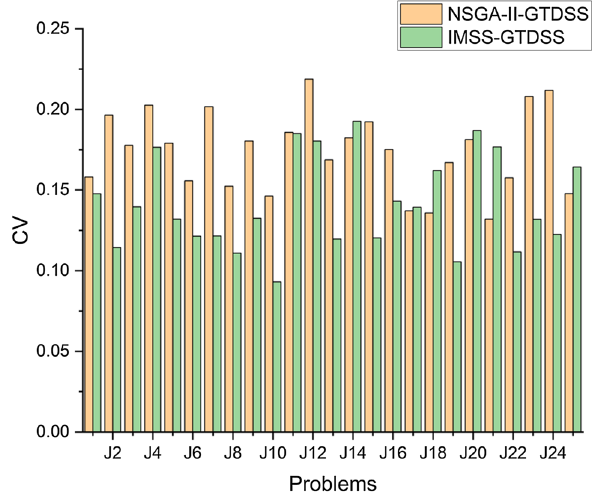
Fig. 14 The energy consumption reduction rate and makespan reduc- tion rate of IMSS-GTDSS